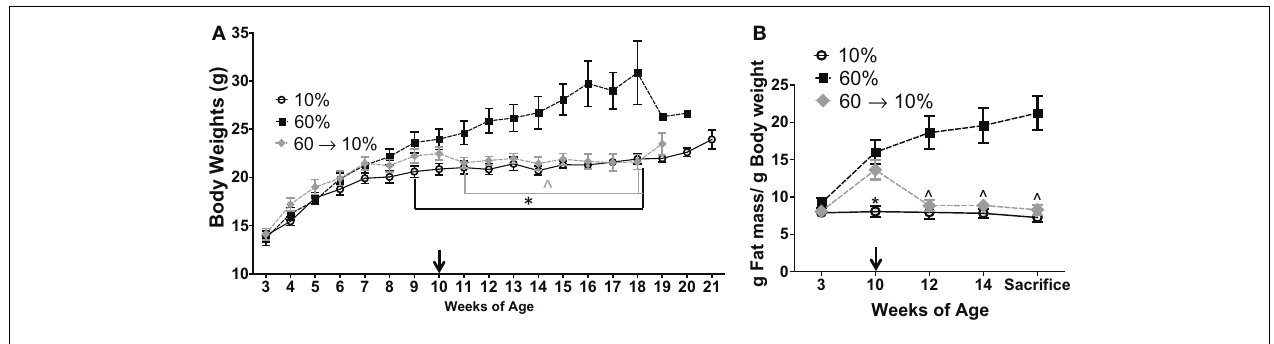
60%). (B) Body composition was measured by MRI at indicated weeks. Diet switch from 60% to control 10% diet is indicated with arrow in (A,B) . (* P < 0.05 vs. both 60 and 60 → 10%; ∧ P < 0.05 vs. 60%). n = 15 in each diet group.